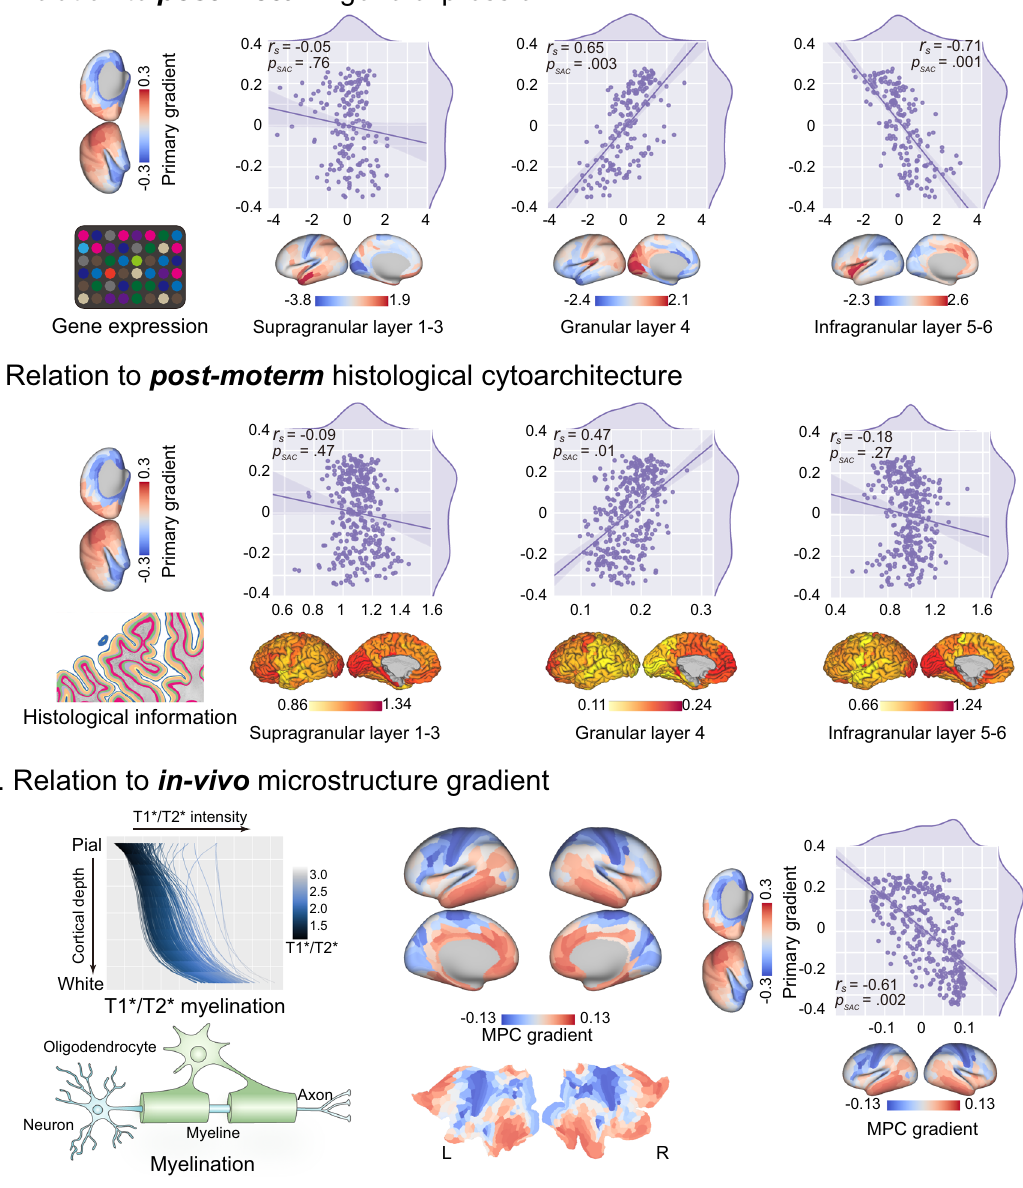
Fig. 3 Layer-speci fi c characteristics of the primary gradient. a The primary gradient differentially correlated with layer-related gene expression, involving no correlation with the supragranular layer (layers 1 − 3) ( r s = − 0.05, p SAC = 0.76), but strong positive correlation with the granular layer (layer 4) ( r s = 0.65, p SAC = 0.003), and strong negative correlation with the infragranular layer (layers 5, 6) ( r s = − 0.71, p SAC = 0.001). b The primary gradient differentially correlated with layer thickness (mm), but had no correlation with the supragranular layer (layer 1 – 3) ( r s = − 0.09, p SAC = 0.47). A strong positive correlation with the granular layer (layer 4) ( r s = 0.47, p SAC = 0.01) and negative correlation with the infragranular layer (layers 5, 6) ( r s = − 0.18, p SAC = 0.27) was also found. c The primary gradient showed a negative association with the axis described by the microstructure pro fi le covariance gradient, which depicted the surface depth-dependent myelination (T1/T2) pro fi le covariation acquired from Paquola et al. 44 MPC, microstructure pro fi le